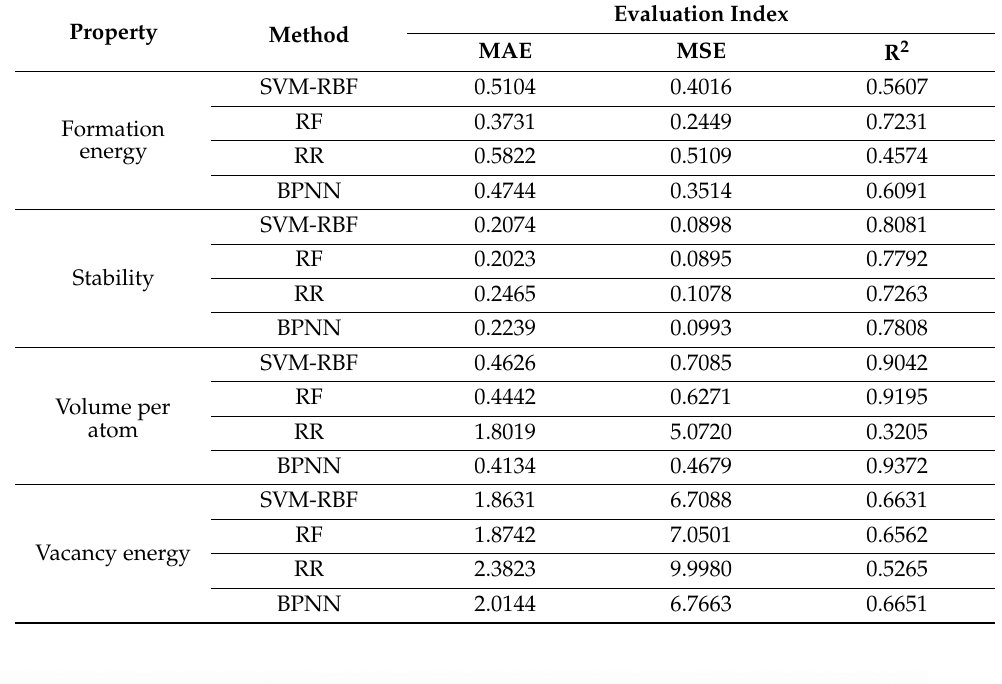
Table 2. Prediction results of four models on test set.